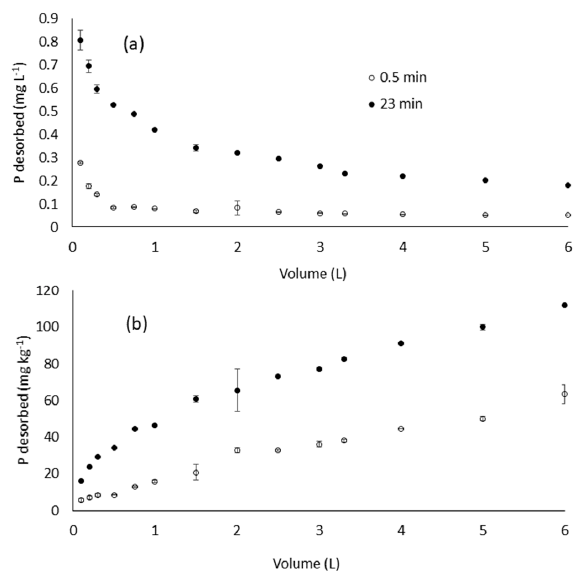
Figure 3. Phosphorus (P) desorption results from the batch hybrid test (variable volume and constant time). Phosphorus desorbed at several volumes and constant time corresponding to the flow-through contact time for fast (0.5 min) and slow (23 min) rates. Phosphorus desorption is expressed as solution concentration ( a ) and cumulative P desorbed ( b ). Error bars = standard deviation.